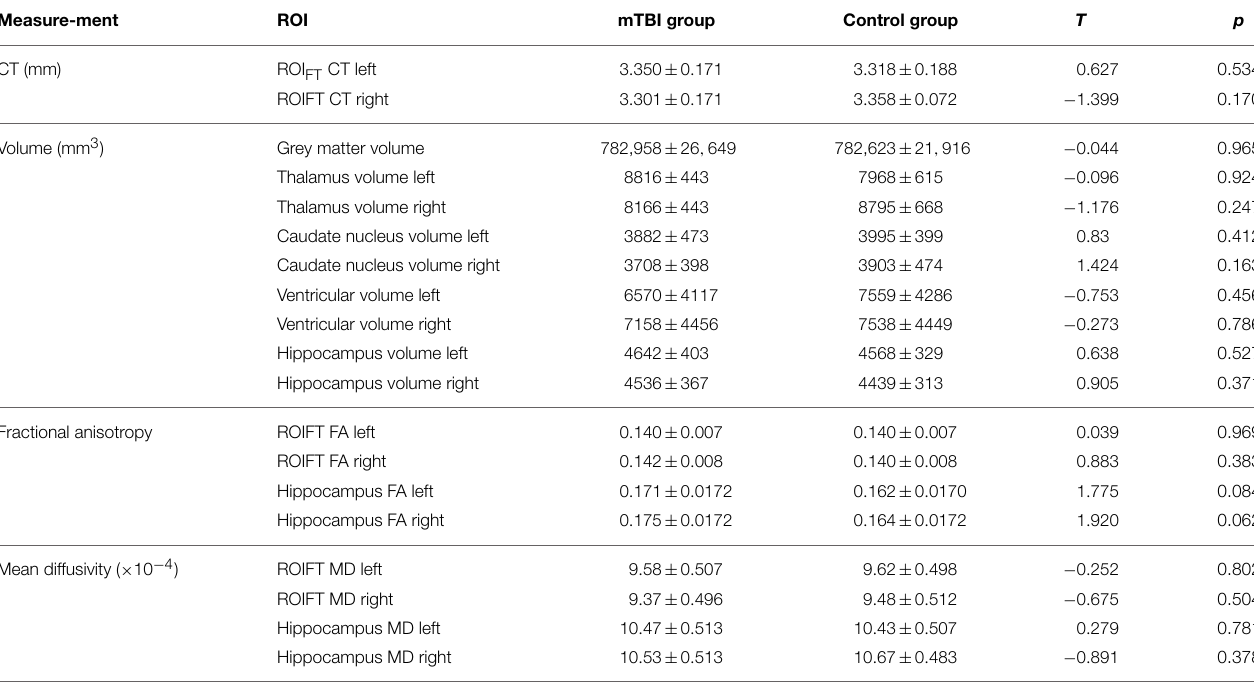
TABLE 3 | Morphometric and diffusion MRI data of mTBI group and control group.